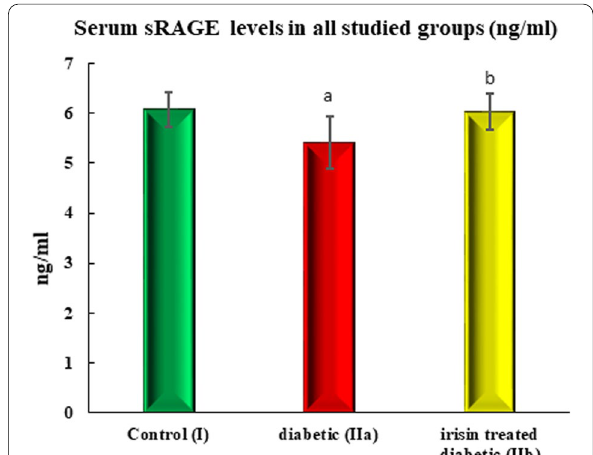
Fig. 1 Soluble Receptor of Advanced Glycation End Products (sRAGEs) levels in all studied groups. Data are expressed as mean SD. a : significant compared to group I; b : significant compared ± to group